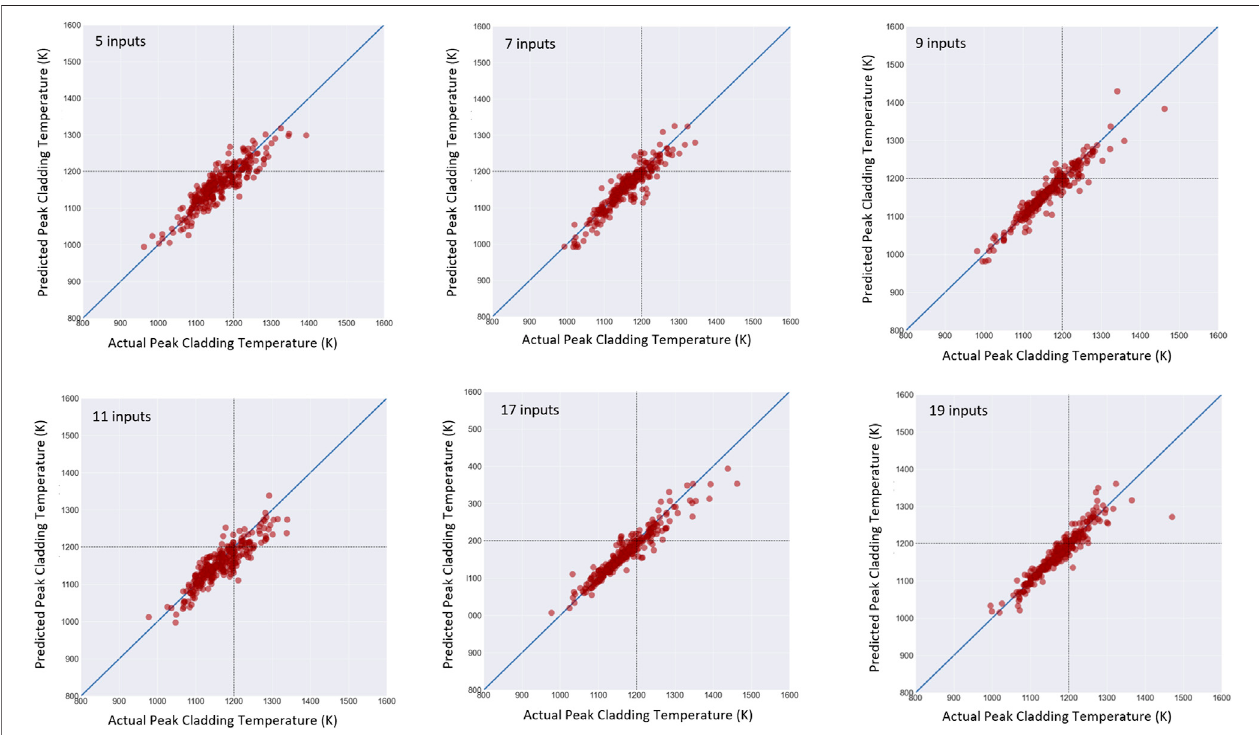
FIGURE 6 | Scatter plot for PCT using different number of uncertain parameters as